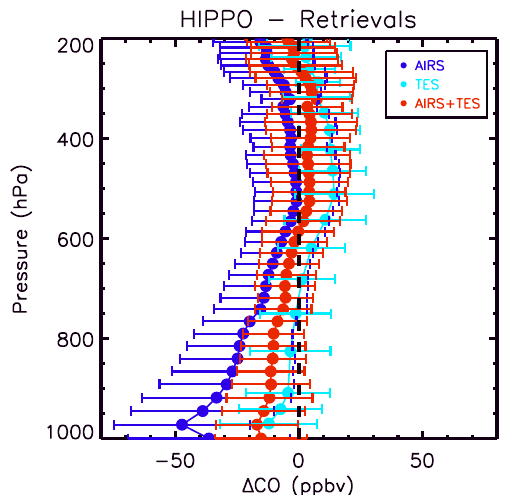
Fig. 10. The differences between AIRS (blue), TES (cyan), and the combined CO (red) and CO from both HIPPO-1 and HIPPO-2 flights at 41 vertical levels. Related error bars are computed from the 1-sigma standard deviations of the differences between the observations and the retrievals. Positive differences indicate that the data fusion approach works well such that the lower troposphere analyzed CO compared to AIRS CO and mid-troposphere analyzes CO compared to TES CO have errors that have been reduced by more than half in both cases.